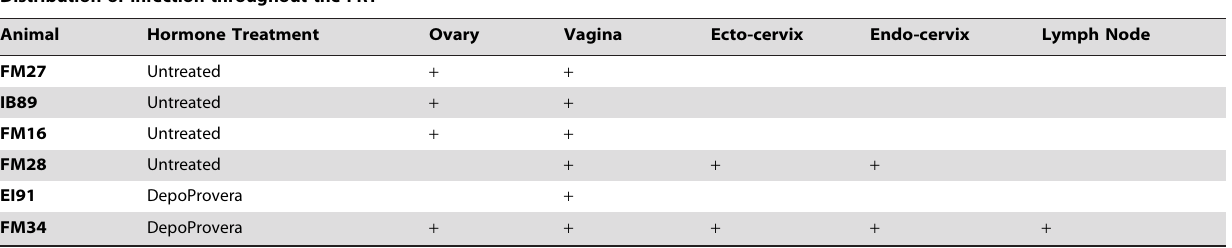
Distribution of infection throughout the FRT Animal Hormone Treatment Ovary Vagina Ecto-cervix Endo-cervix